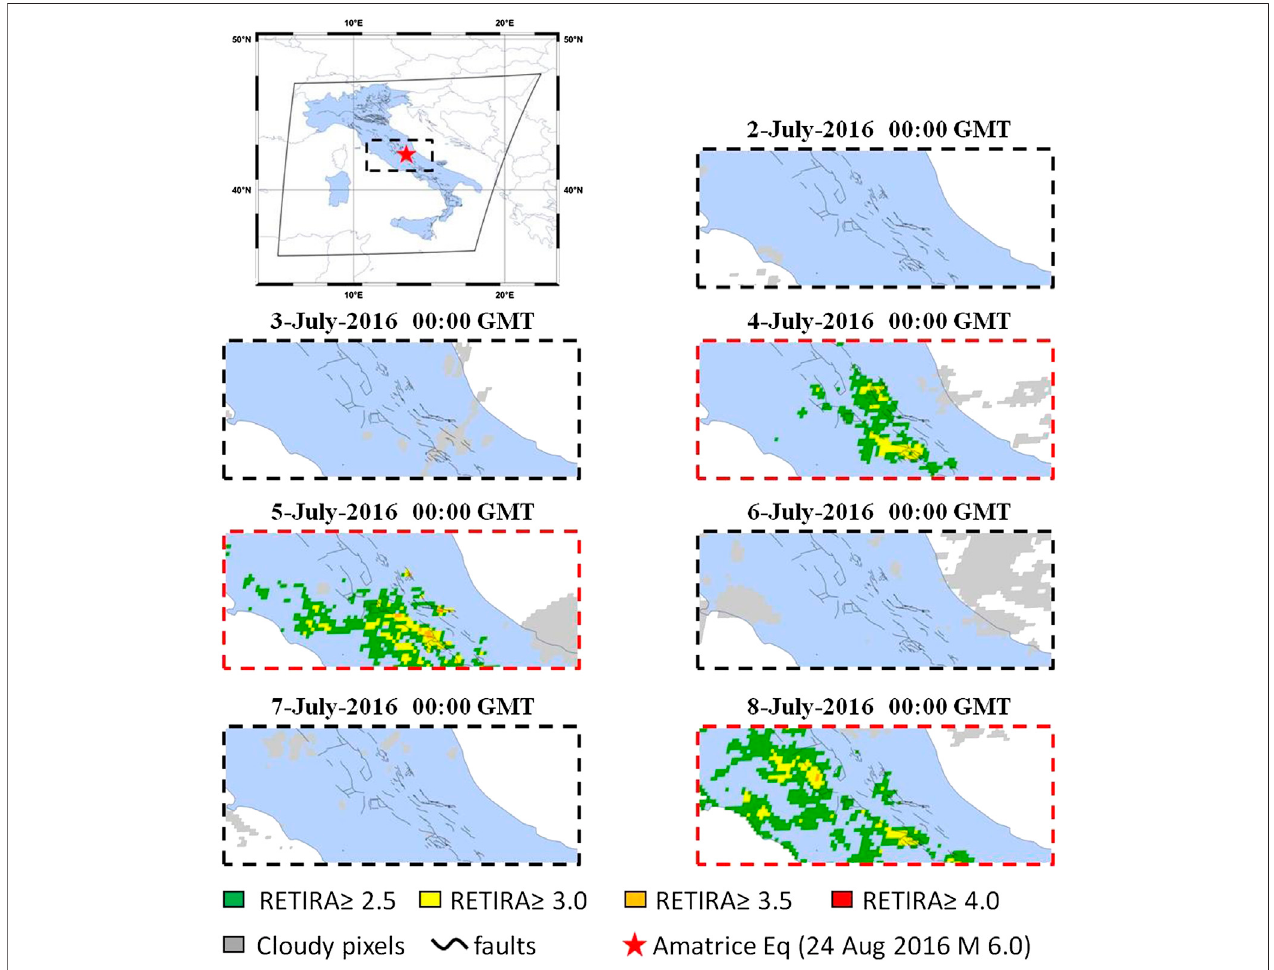
FIGURE 3 | Example of sequence of TIR anomalies. The RETIRA index over Central Italy at the time of Amatrice earthquake (August 24, 2016, M W 6.0) (upper left box) was computed also considering low intensity anomalies (i.e., by considering pixels with ⊗ Δ T ( x , y , t ) > 2.5). Generally, low intensity anomalies follow high intensity anomalies, noticeably enlarging the anomaly area and fi lling gaps in both space (among isolated anomalous pixels) and time domains.